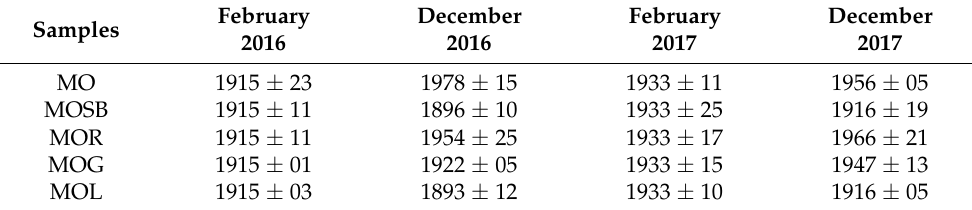
Table 9. Total sterols (mg/kg) of all olive